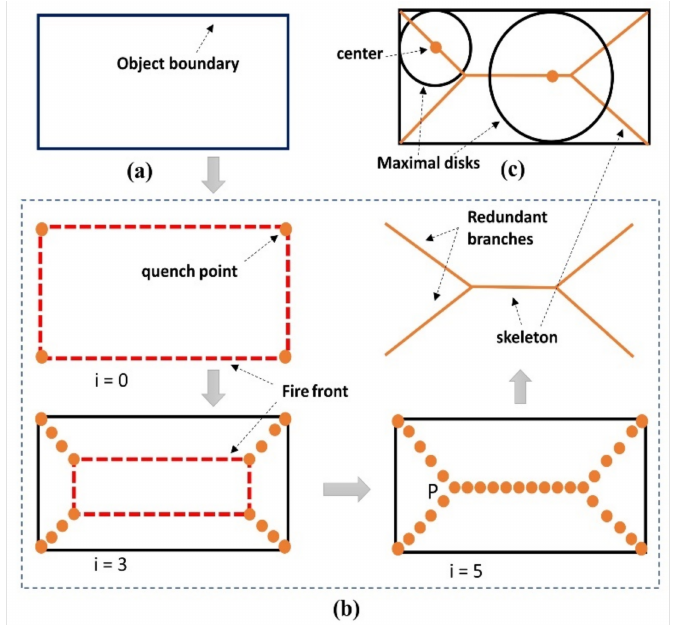
Figure 3. Schematic illustration of grassfire model on a rectangular polygon. ( a ) Rectangular polygon; ( b ) the evolution of grassfire model, i indicate iteration starting from i = 0, fire front indicates set of points where boundary grass is lit, quench point indicates location where opponent fire front meet; ( c ) schematic of skeleton by medial axis